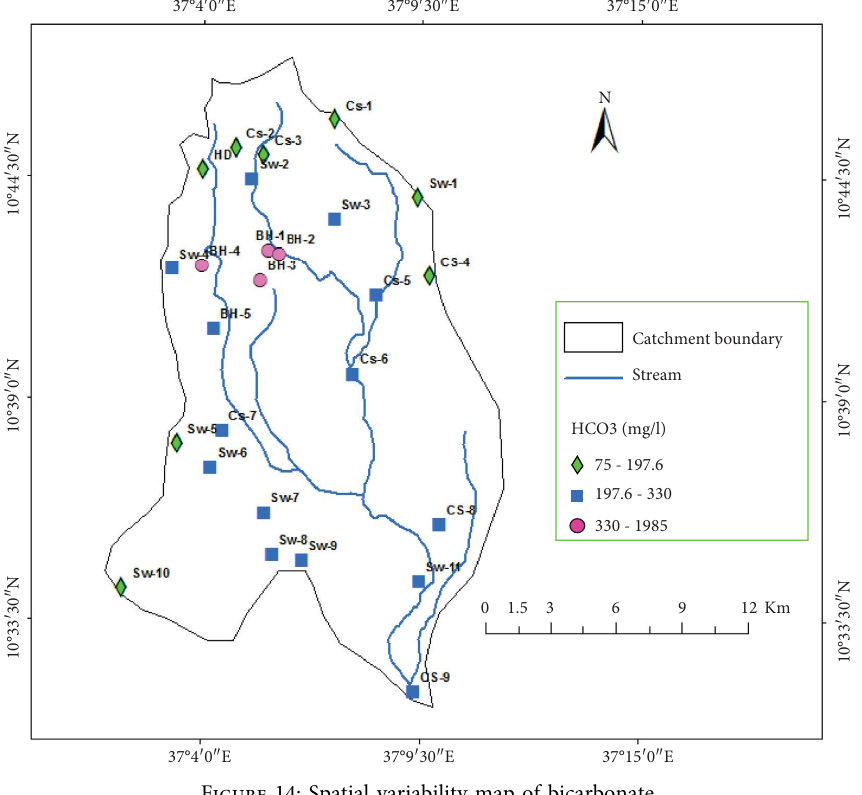
Figure 14: Spatial variability map of bicarbonate.